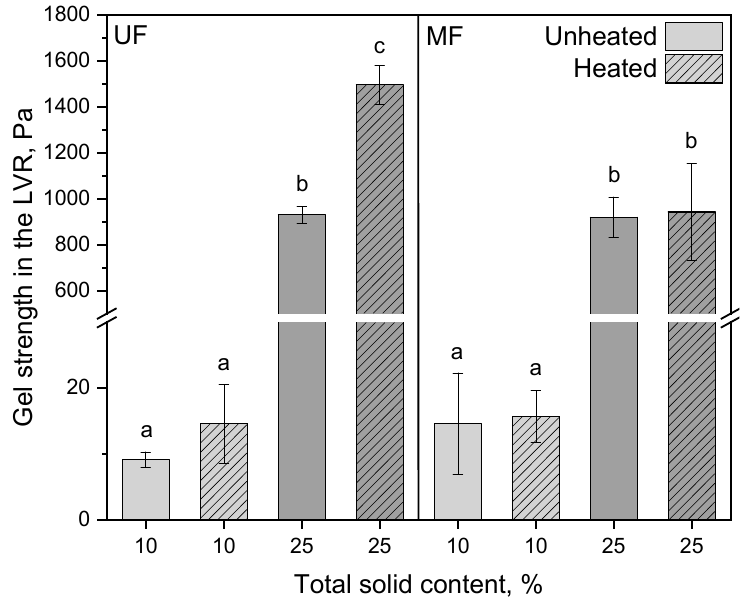
Figure 5. Gel strength in the linear viscoelastic region (LVR) of unheated and heated reconstituted UF and MF rennet gels with 10 and 25% total solid content. Letters indicate the statistical significance at p ≤ 0.05.